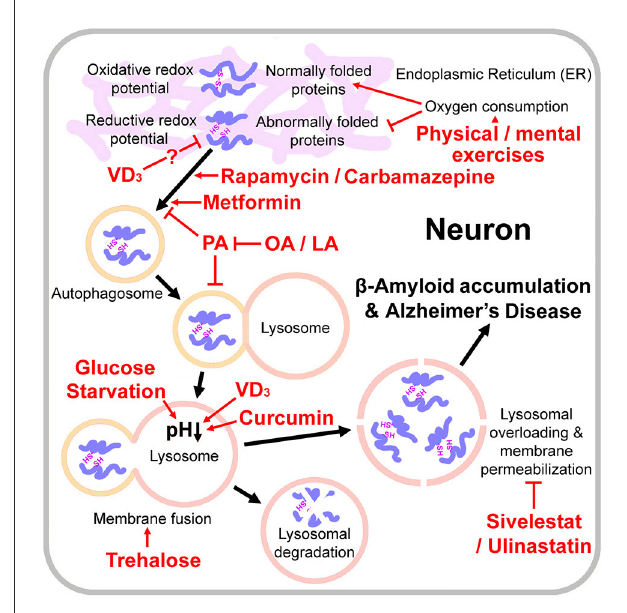
FIGURE1 Pathogenesis of Alzheimer s disease and the relevant drugs and dietary therapies. Physical / mental exercises generate the oxidative redox potential required to oxidize the free sulfydryl groups of cysteine into the disulphide bonds for proper protein folding. Lysosomal overloading (misfolded protein over-accumulation) induces lysosomal membrane permeabilization, amyloid β -protein accumulation and Alzheimer’s disease onset. VD 3 activates protein disulfide isomerase family A member 3 and thus may reduce misfolded proteins. Rapamycin, carbamazepine and metformin are autophagy stimulators. Glucose starvation, trehalose, VD 3 , and curcumin promote autophagosome-lysosome fusion and/or lysosomal acidification. Lysosome integrity protectants Sivelestat and Ulinastatin may also protect neurons from lysosomal-mediated cell death. Palmitic acid (PA) causes autophagy impairment; however, oleic acid (OA) or linoleic acid (LA) counteracts PA’s detrimental effects on